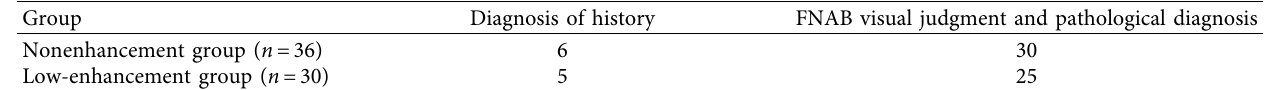
Table 2: Diagnostic methods used in the diagnosis of mummified